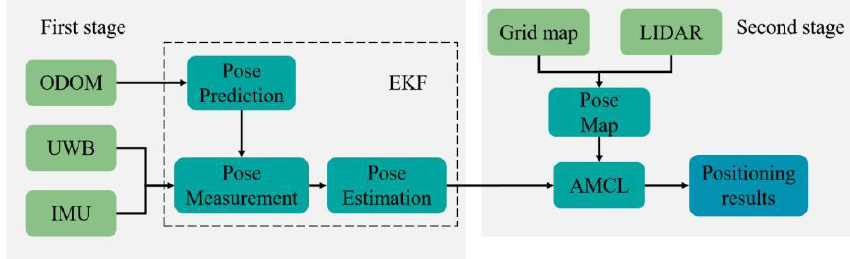
Figure 2. Integrated positioning frame diagram based on UWB/IMU/ODOM/LIDAR.